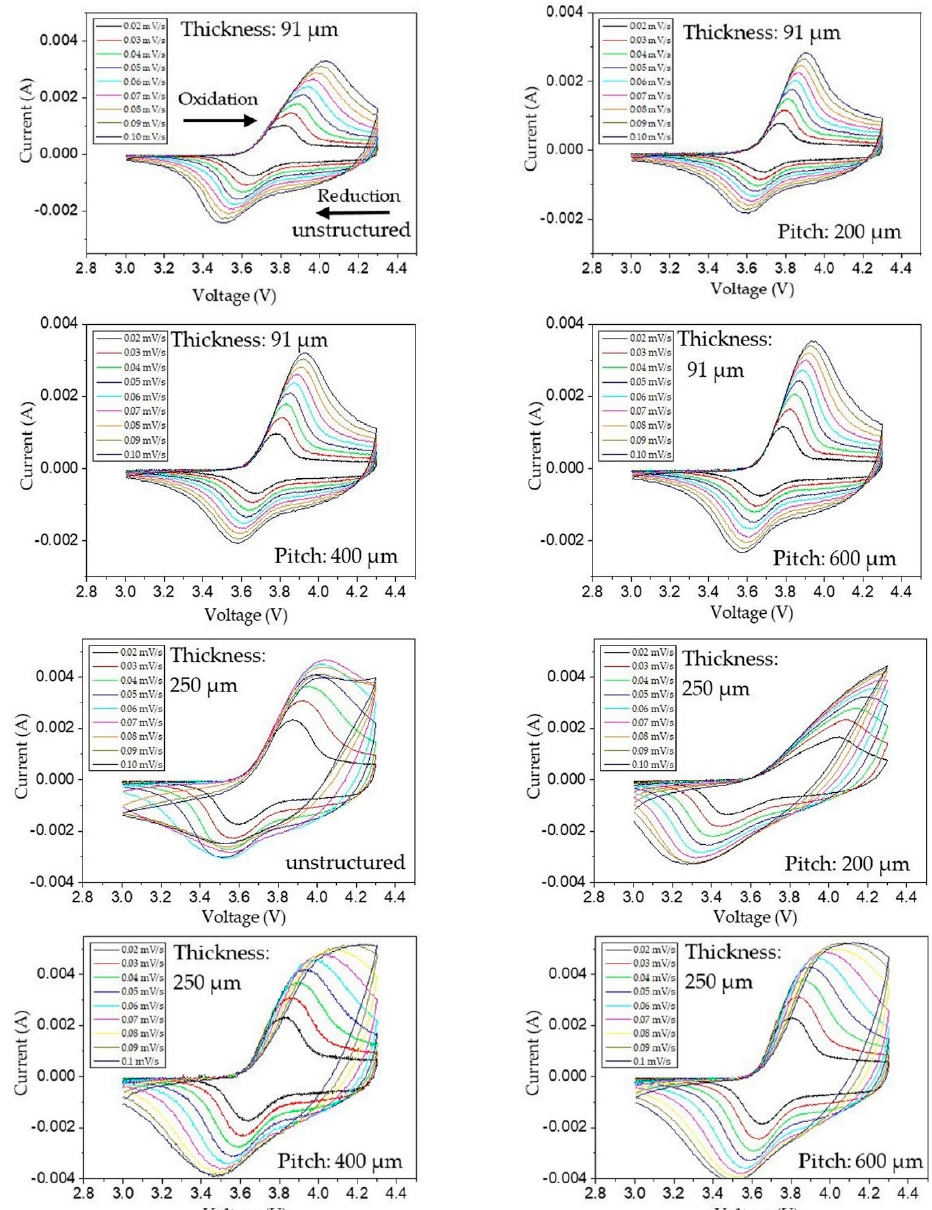
Figure 5. CV analyses of cells containing unstructured cathodes and structured cathodes with different pitch distances (film thicknesses: 91 µm and 250 µm).